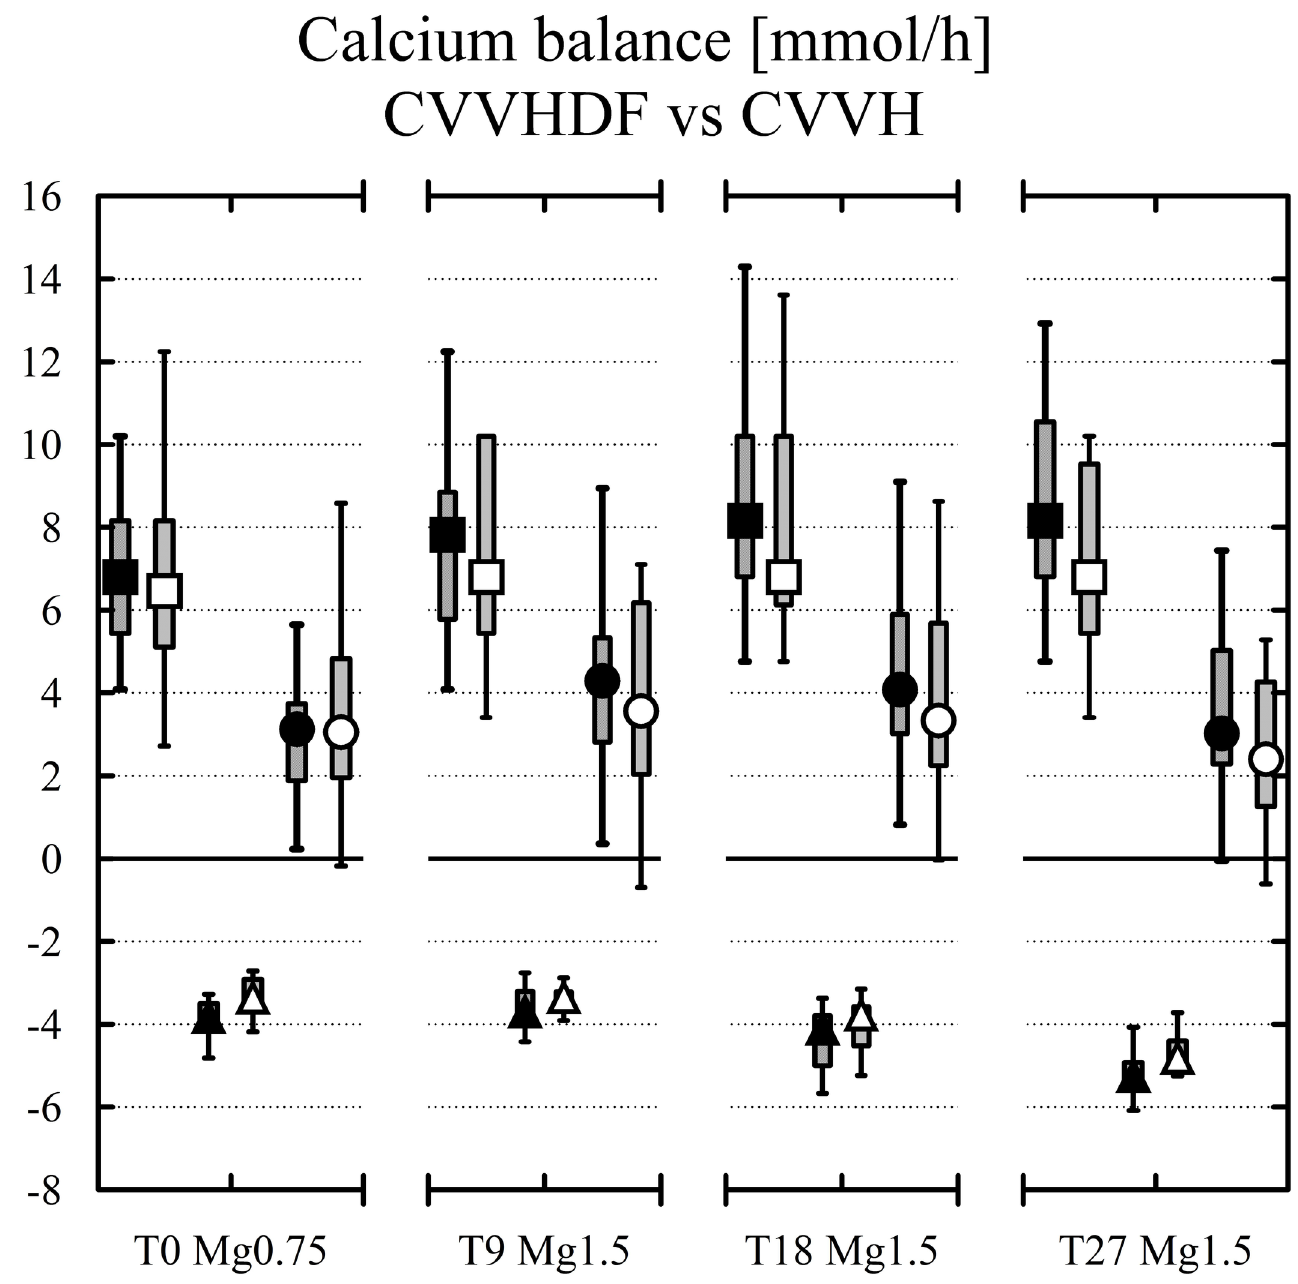
Fig 5. Calcium inputs (black squares for CVVHDF and white squares for CVVH, both above zero) vs calcium losses (black triangles for CVVHDF and white triangles for CVVH). The final balances at each study time (black and white circles) are in the middle. Median, IQR in boxes, Min-Max in